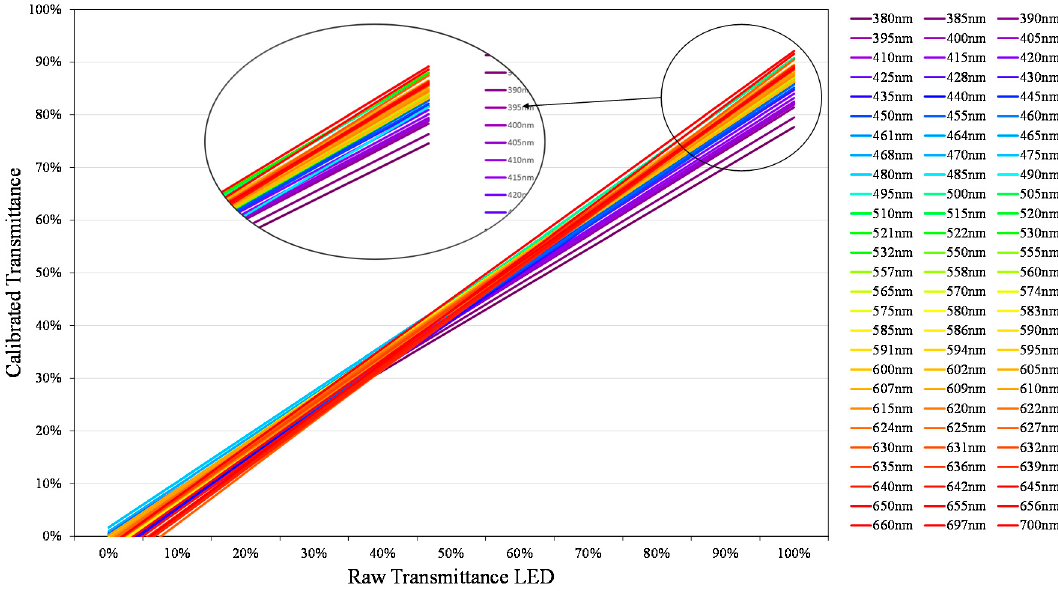
Figure 16. Calibration lines between 380 and 700 nm.